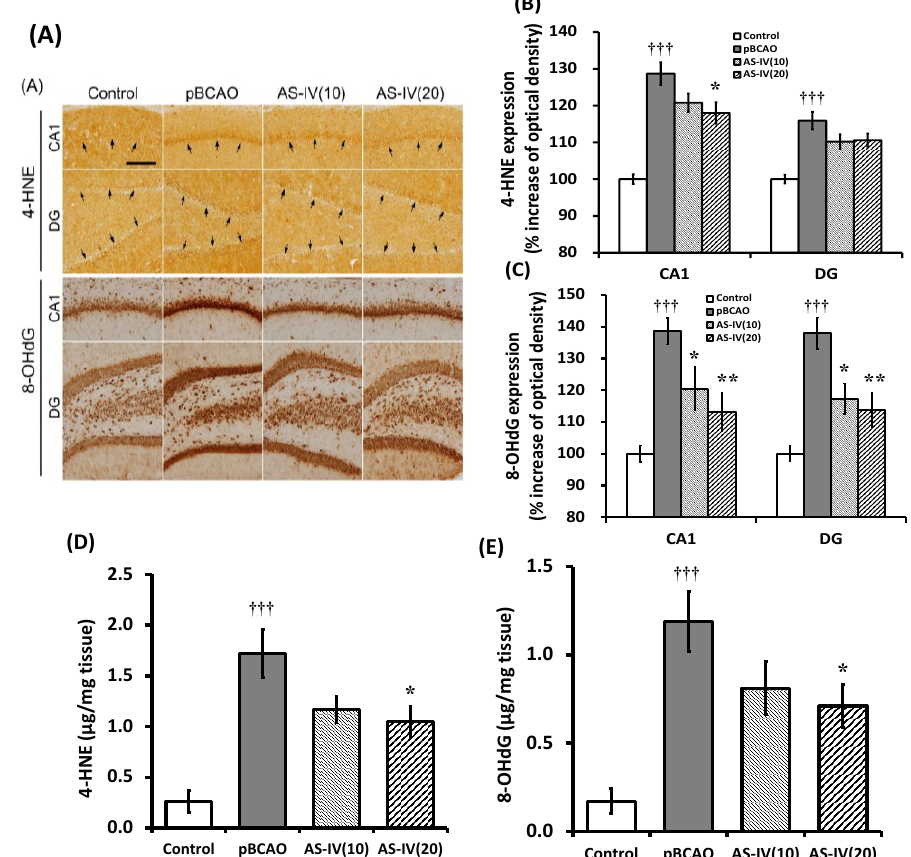
Figure 6. Effects of astragaloside IV (AS-IV) on 4-HNE and 8-OHdG expressions in hippocampal tissue. Representative photographs show the CA1 and DG regions of the hippocampus immuno-stained against 4-HNE and 8-OHdG ( A ). Scale bar is 100 µm, applicable to all sections. AS-IV at 20 mg/kg significantly attenuated the upregulation of 4-HNE expression in the CA1 of the hippocampus ( B ). AS-IV 10 and 20 mg/kg treatment significantly attenuated the upregulation of 8-OHdG expression in the CA1 and DG regions of the hippocampus ( C ). AS-IV treatment at 20 mg/kg significantly attenuated the upregulation of 4-HNE and 8-OHdG protein levels as determined by ELISA method ( D , E ). Data are presented as mean ± SEM ( n = 6 in each group; ††† , p < 0.001 between the control and the pBCAO groups; * , p < 0.05; ** , p < 0.01 between the pBCAO and AS-IV